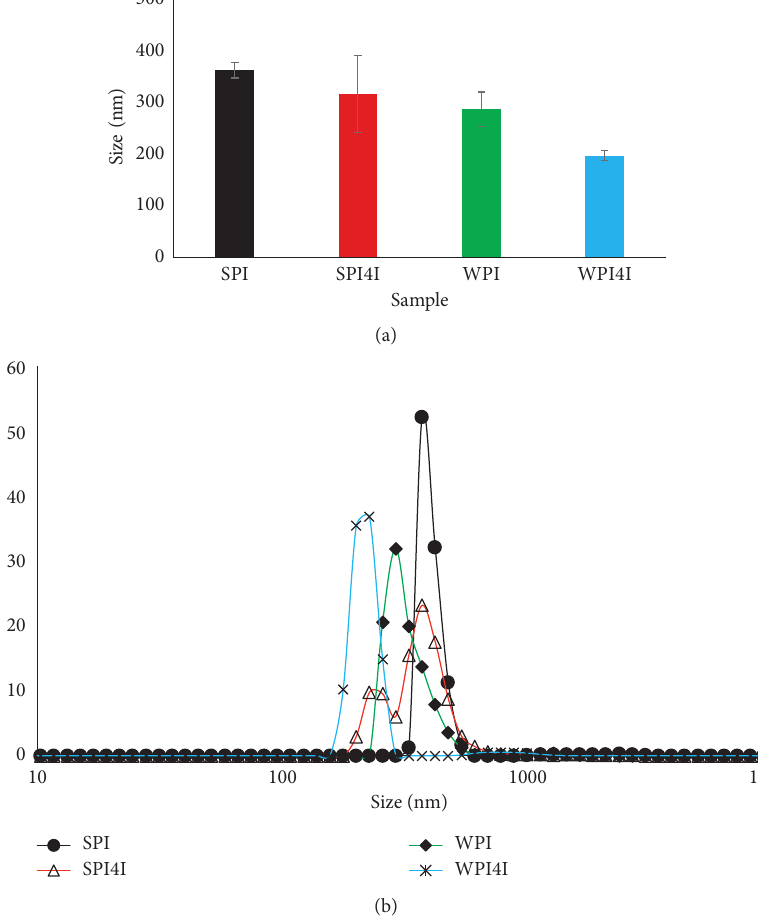
Figure 1: Particle size (a) and size distribution (b) of encapsulated L. reuteri bacteria; SPI: soy protein isolate 20%, SPI4I: soy protein isolate 20% +inulin 4%, WPI: whey protein isolate 20%, WPI4I: whey protein isolate 20%+inulin